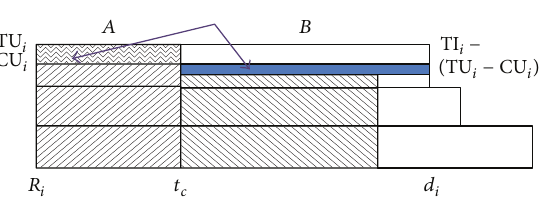
Figure 5: Slack exchange process.